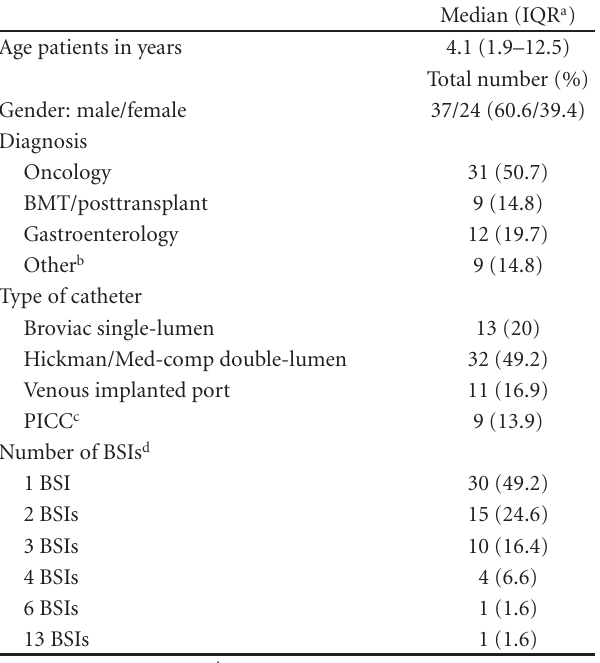
Table 1: Patient